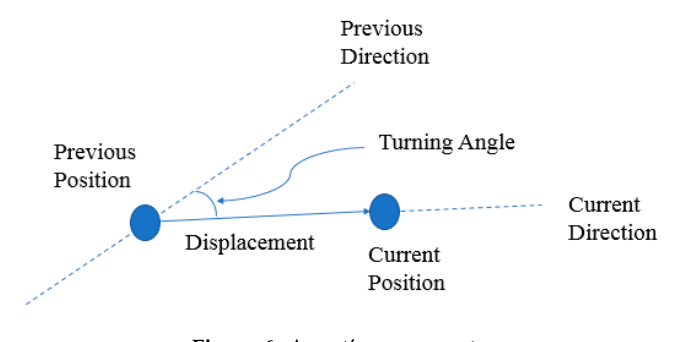
Figure 6. Agent’s Figure 6. Agent’s movement.